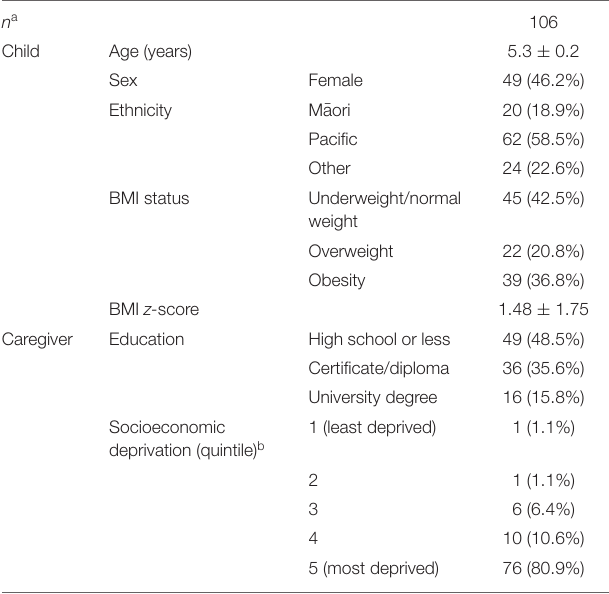
TABLE 1 | Sociodemographic characteristics of participants.